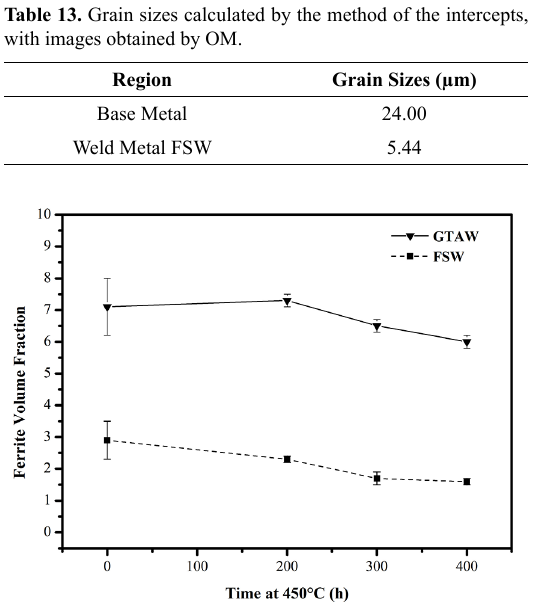
Figure 7. Variation of ferrite volume fraction with time of exposure at 450°C.